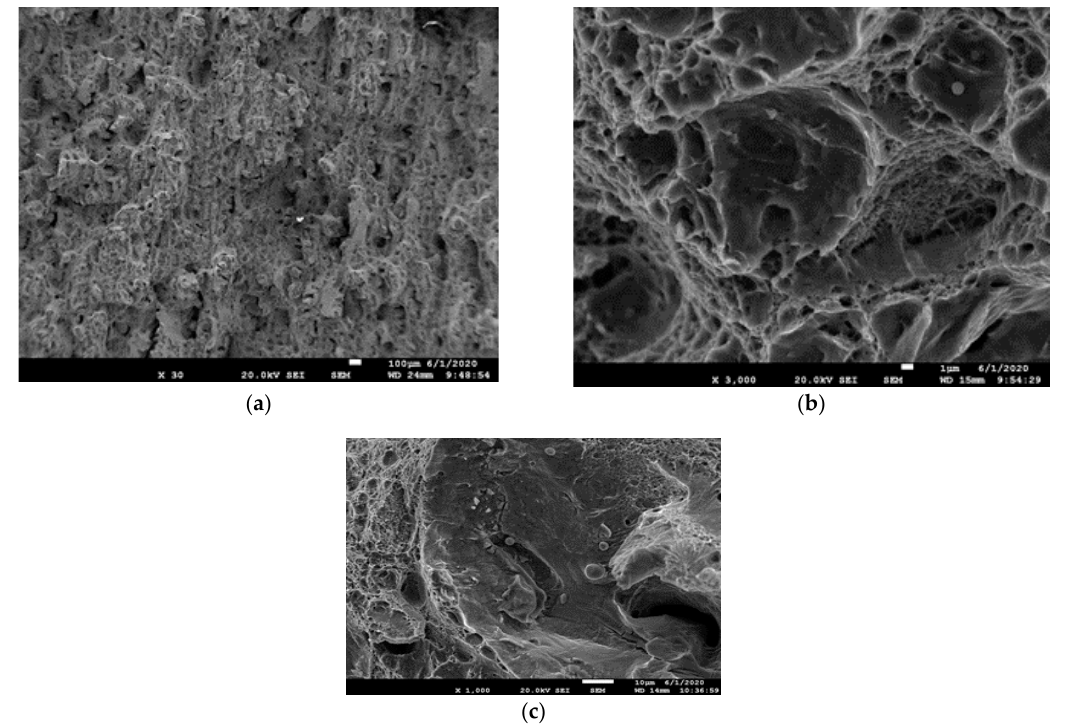
Figure 13. Stripes family 2 (samples 4–6) with ( a ) illustrating the absence of continuous propagation along fusion zones, ( b ) larger dimples and ductile ridges, and ( c ) oxide inclusions.